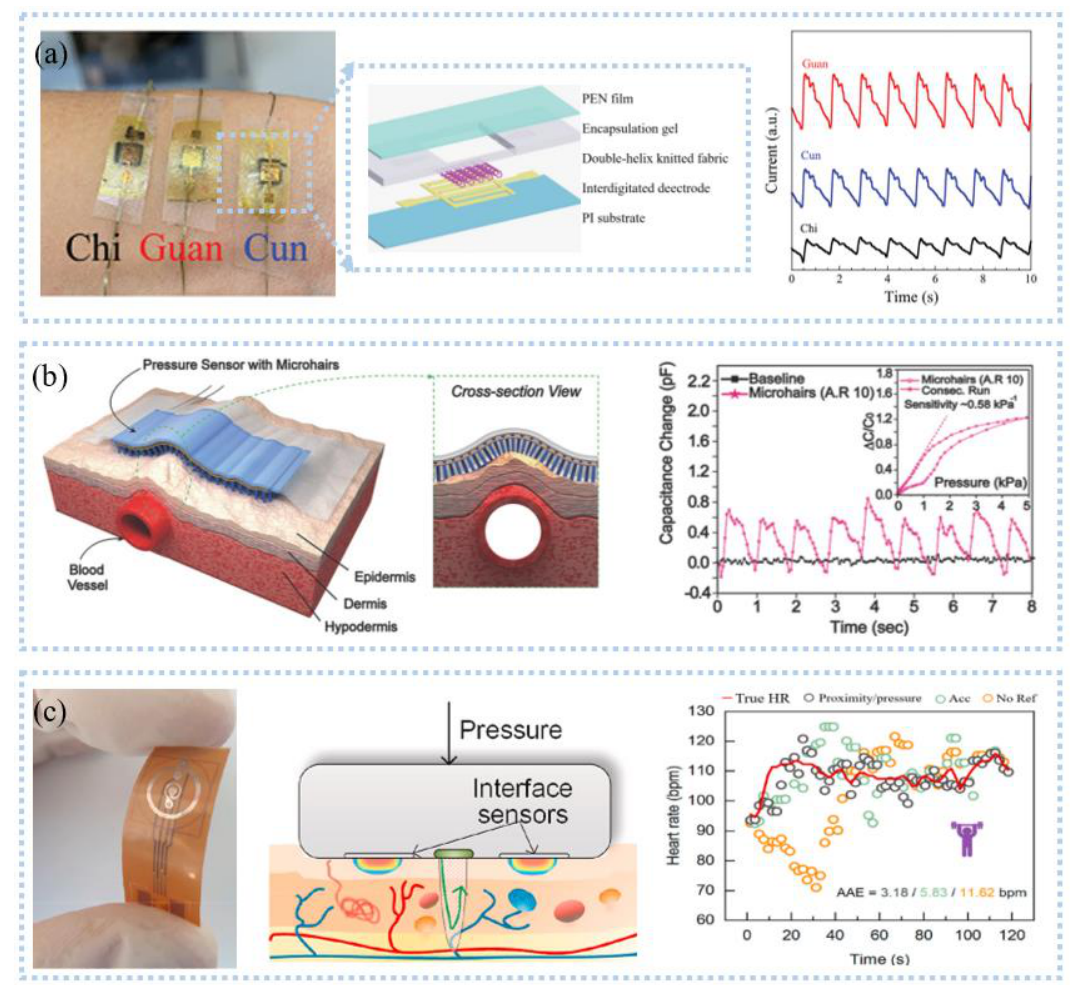
Figure 7. Heart rate and pulse detection: ( a ) The 1 × 3 sensor array for pulse detection (left), the twisted yarn with a double−helix configuration (middle), and pulse on the position of “Cun”, “Guan”, and “Chi” (right). Reprinted with permission from Ref. [94]. Copyright 2021 John Wiley and Sons, ( b ) Schematic illustration to detect pulse (left) and the sensitivities (right). Reprinted with permission from Ref. [97]. Copyright 2015 John Wiley and Sons, ( c ) A photograph of the interface sensor (left), the principle of interface sensor for perceiving contact pressure on the skin (middle), and HR estimation results for weightlifting (right). Reprinted with permission from Ref. [98]. Copyright 2021 Elsevier.